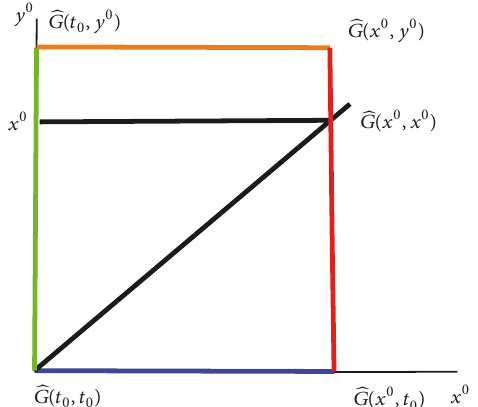
̂𝐺(𝑥 0 ,𝑦 0 ) . We show the paths for the